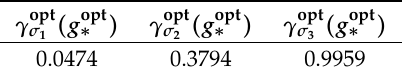
Table 4. Fixed-point values of γ σ η N = − Z − 1 ∂ t Z k k